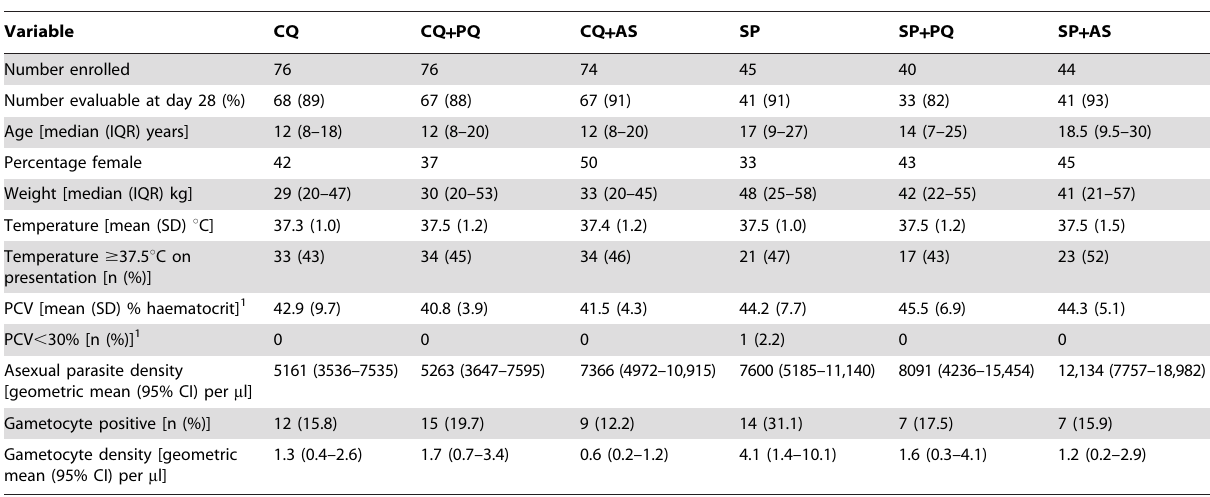
Table 2. Enrolment characteristics of the treatment groups.